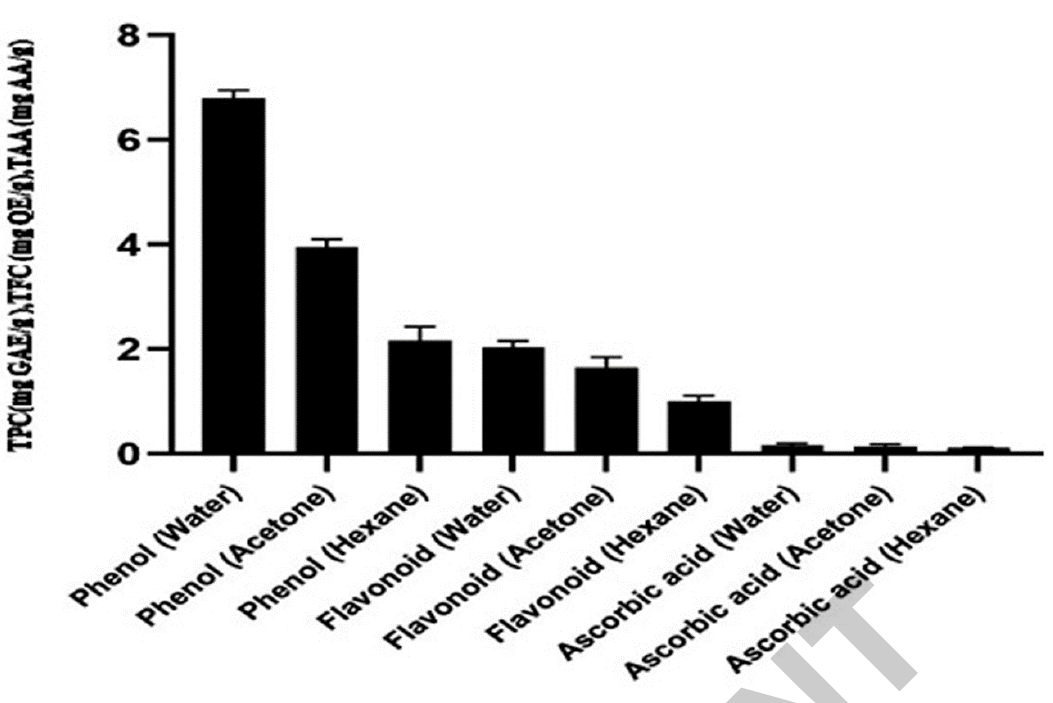
Figure 7 Total phenol, flavonoid, and ascorbic acid contents of Astraeus asiaticus in the hot water, acetone, and hexane